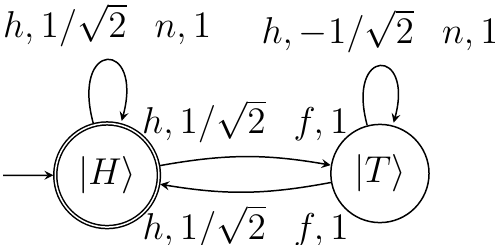
Figure 2. A simple example of the quantum periodic automaton accepting the infinite sequence of movements in PQ-PENNY game (see [47] for details). The measurement period is m = 3 (it is equal to the number of movements to complete a simple